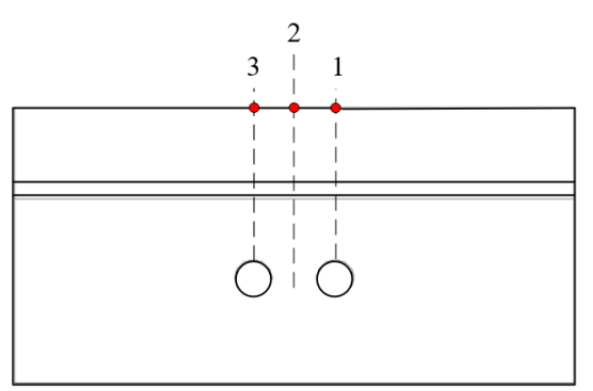
Figure 6. Arrangement of surface monitoring points at the position of 10 m depth in excavation direction.